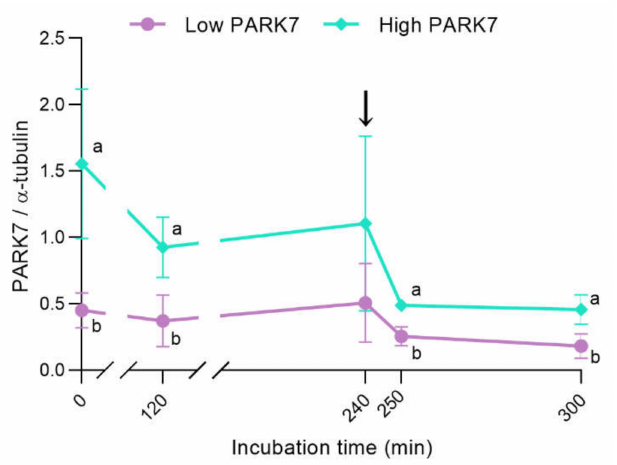
Figure 1. Relative PARK7 content (standardized against α -tubulin levels) during in vitro capacitation and acrosomal exocytosis induced by progesterone. The black arrow indicates the addition of progesterone at a final concentration of 10 µ g/mL (240 min). Results are shown as the mean of PARK7/ α -tubulin ratio ± SD. Different letters indicate significant differences ( p < 0.05) between sperm samples with high and low PARK7 content.